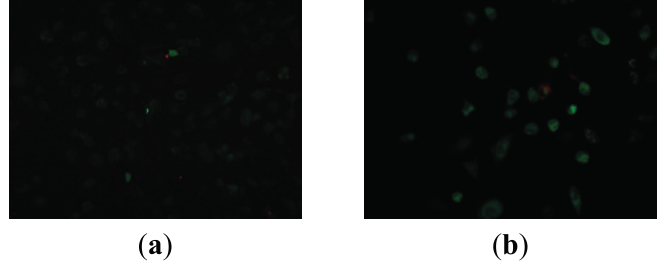
Figure 7. ROS generation assay of compound 9n in HeLa cells. ( a ) Cells not treated with compound 9n were used as control for 12 h and ( b , c ) treatment with compound 9n (10, 15 μ M) for 12 h, respectively.